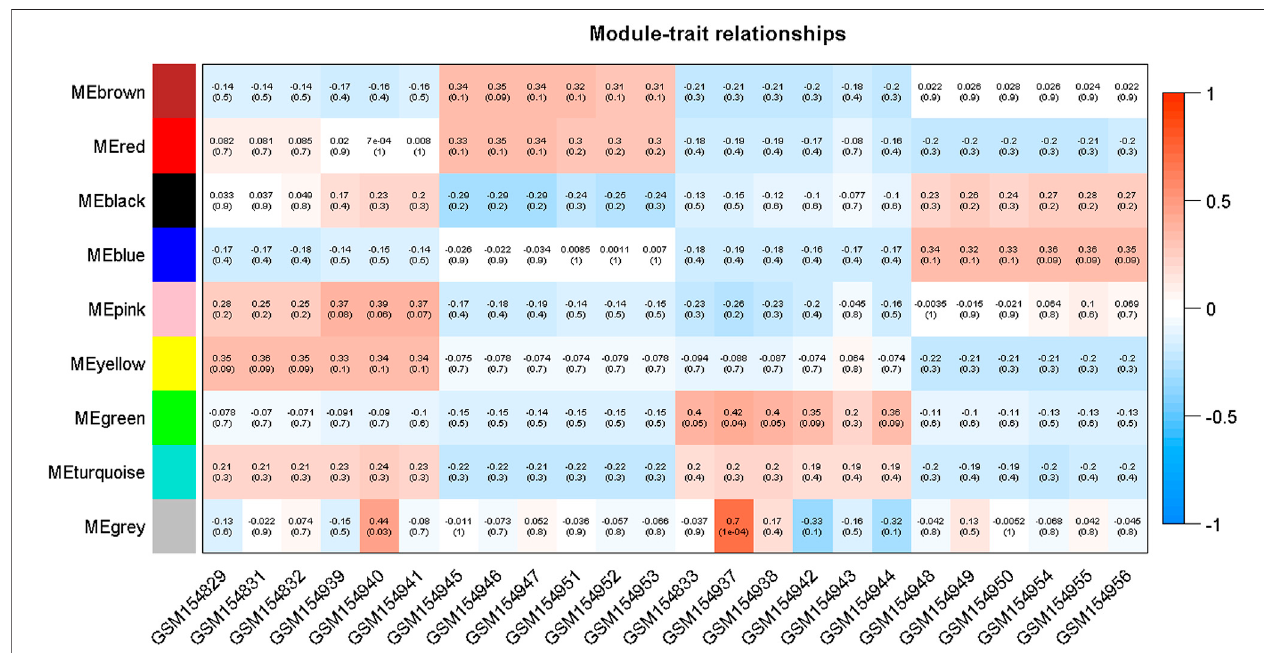
FIGURE 6 | Module-trait associations where each row corresponds to a module or eigengene and a column to a trait. Each cell contains the corresponding correlation and p -value. The table is color-coded by correlation according to the color legend mentioned in the Figure.